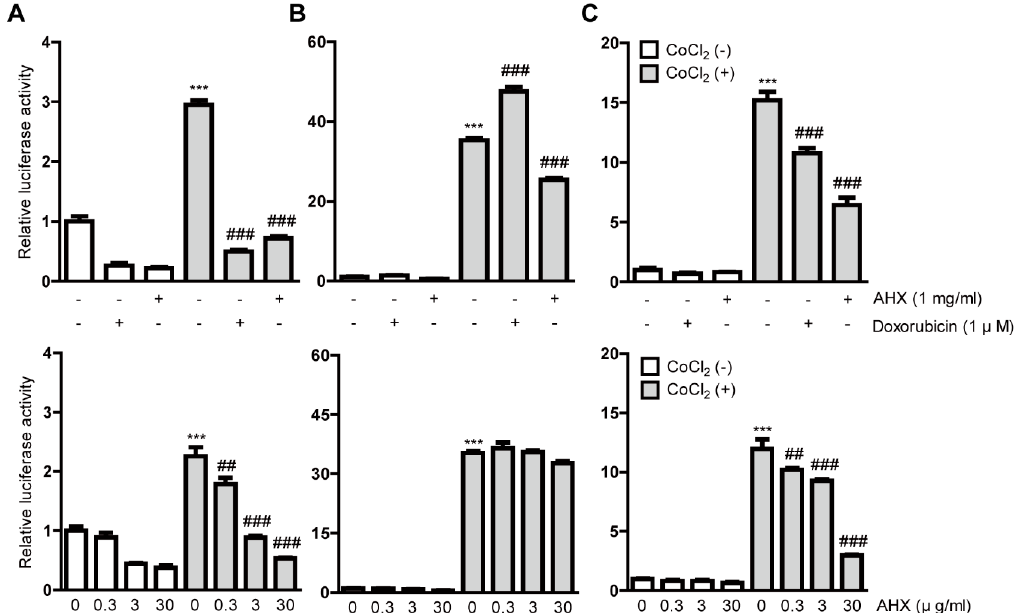
Figure 1. Inhibitory effects of AHX isolated from mushrooms on HIF activation. Quantitative analyses of the HIF-reporter luciferase assays using ( A ) 3T3, ( B ) ARPE-19 and ( C ) 661W cells ( n = 3–6 per group) showed that AHX inhibited HIF activity induced by 200 µM CoCl 2 in all of the cell lines. *** p < 0.001, ## p < 0.01, ### p < 0.001 compared with no treatment and 200 µM CoCl 2 treatment, respectively. Bar graphs are presented as the mean with the ± standard error of the mean. The data were analyzed using one-way ANOVA followed by a Bonferroni post hoc test.